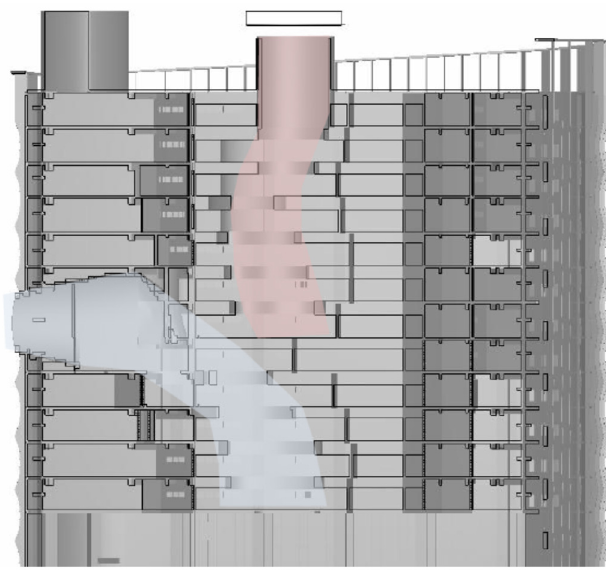
Figure 4. A section of the studied building.